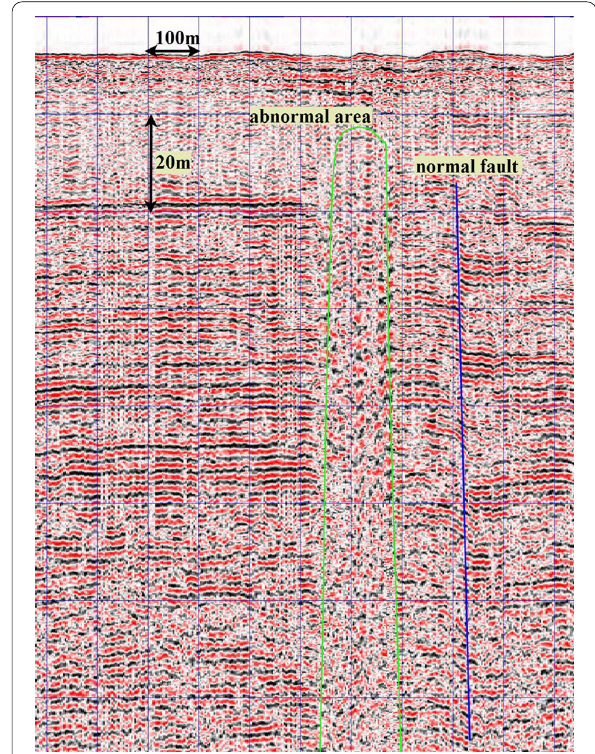
Fig. 6 Acoustic profile 1 in the survey area, and the seismic attribute is